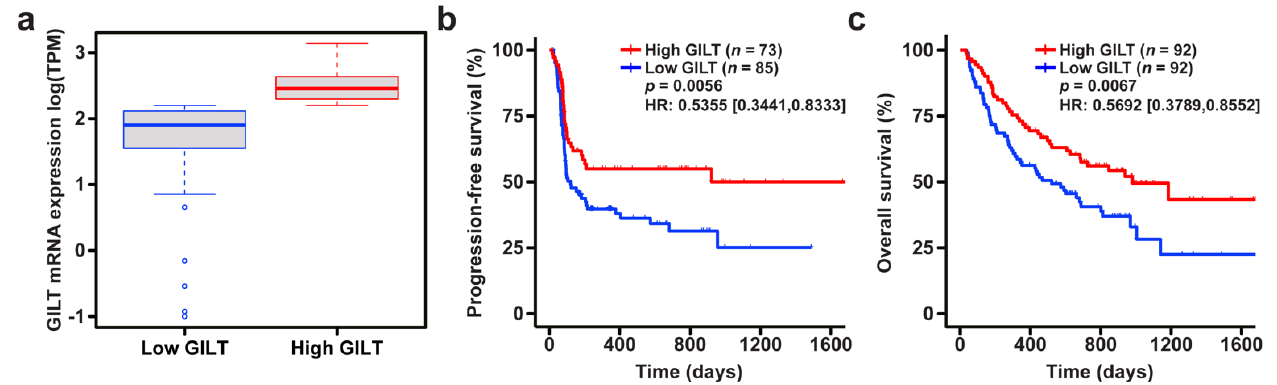
Figure 1. High GILT mRNA expression is associated with improved survival in metastatic melanoma patients treated with immune checkpoint inhibition. ( a ) Distribution of GILT mRNA expression in the high and low GILT categories, split by the median value, in the combined Liu, Van Allen, and Hugo datasets. The bold line in the box plot indicates the median; the upper and lower limits of the boxes indicate the 75th and 25th percentiles, respectively. The lower and upper whiskers indicate the minimum and maximum. Dots outside of the box and whiskers indicate outliers. Association of high and low GILT expression with ( b ) progression-free survival in the combined Liu and Van Allen datasets and ( c ) overall survival in the combined Liu, Van Allen, and Hugo datasets as calculated by a Cox proportional hazards model adjusted for stage and dataset. HR, hazard ratio with 95% confidence interval, indicated in brackets.